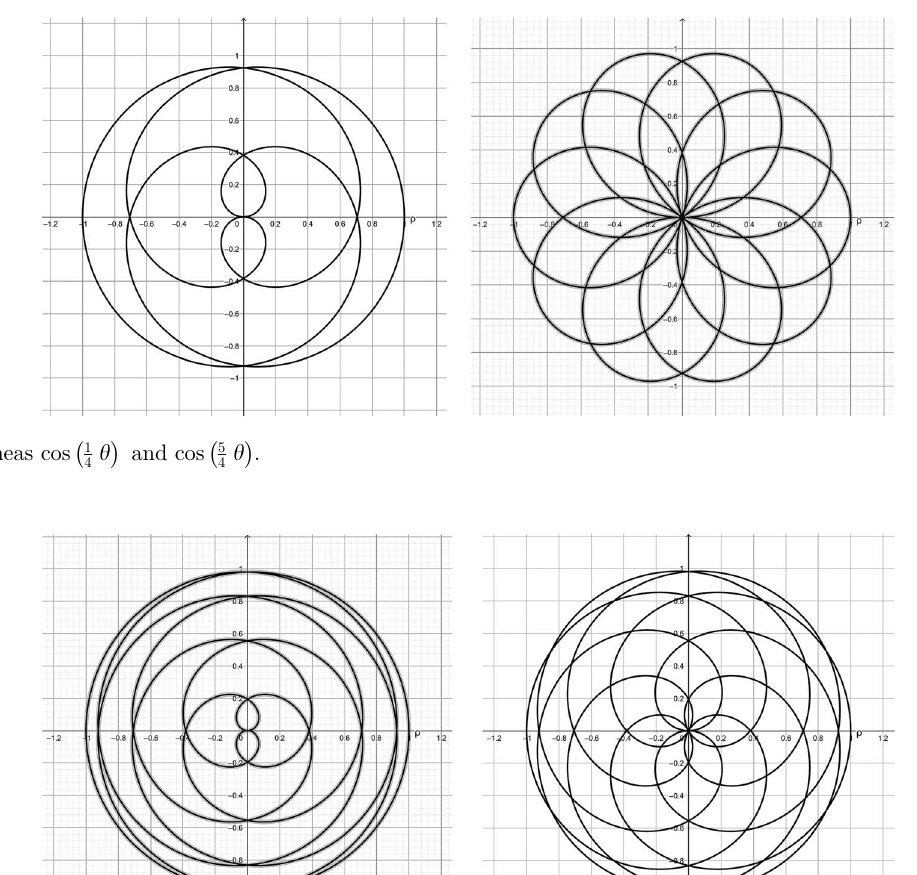
Figure 7. Rodoneas cos 1